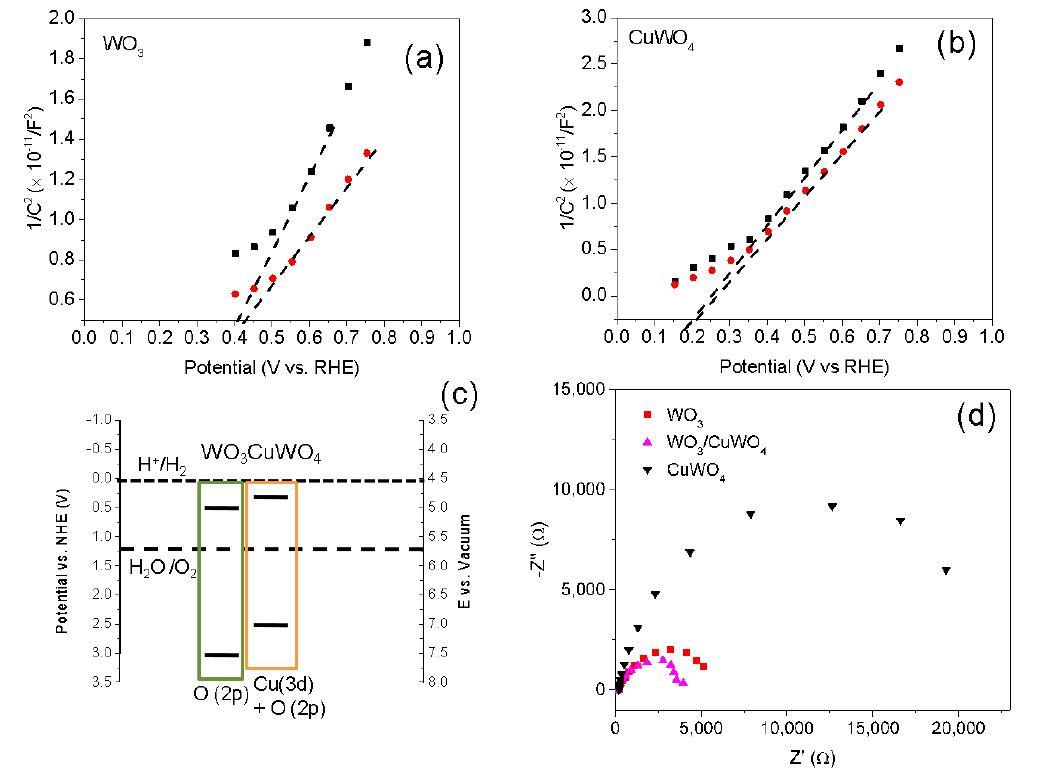
Figure 4. Mott-Schottky plots of WO 3 thin film ( a ); and CuWO 4 thin film ( b ) at 10 k and 5 k Hz under dark conditions; ( c ) Band structure of WO 3 and CuWO 4 ; ( d ) Nyquist plots of WO 3 , WO 3 /CuWO 4 , and CuWO 4 thin films under AM 1.5 illumination in 0.5 M Na 2 SO 4 with 1.20 V RHE applied